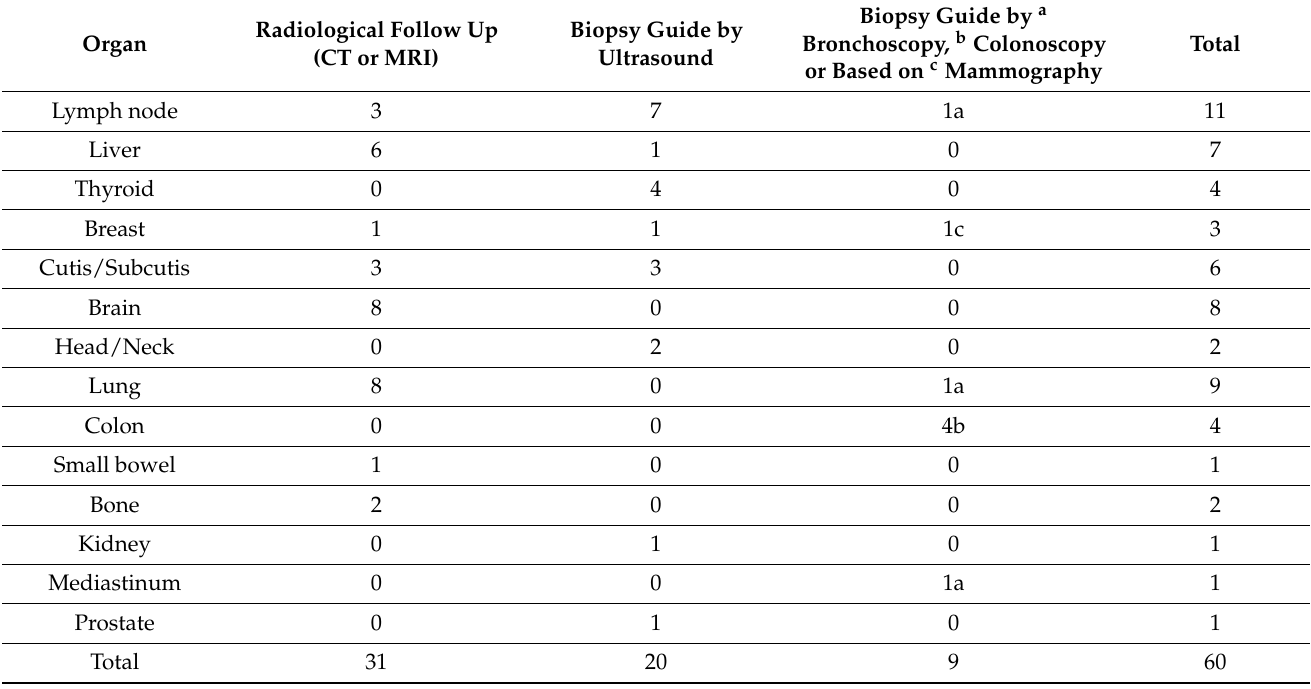
Table 2. All included lesions reported as indeterminate on FDG-PET/CT ( n = 60) were classified as benign or malignant based on the outcome of the required further evaluation (i.e., radiological follow up and/or histopathology). Number of Benign Finding(s) Number of Malignant Number of Indeterminate Organ per Organ Finding(s) per Organ Finding(s) per Organ Lymph node